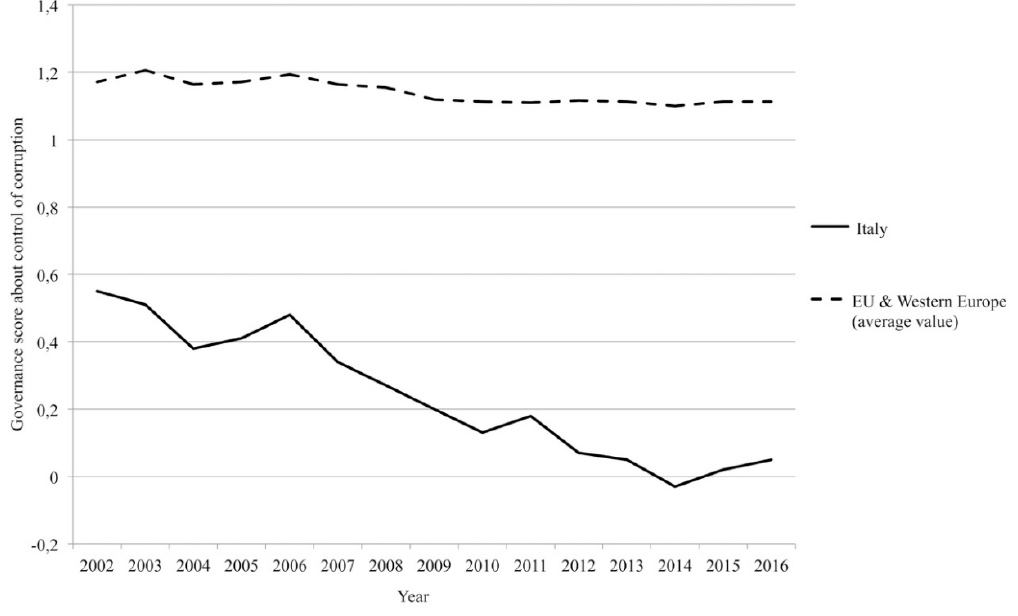
Figure 2. Control of corruption by the Italian government and by the EU and Western Europe governments (average value) for the period between 2002 and 2016. Source: World Bank (2016), Worldwide Governance Indicators.